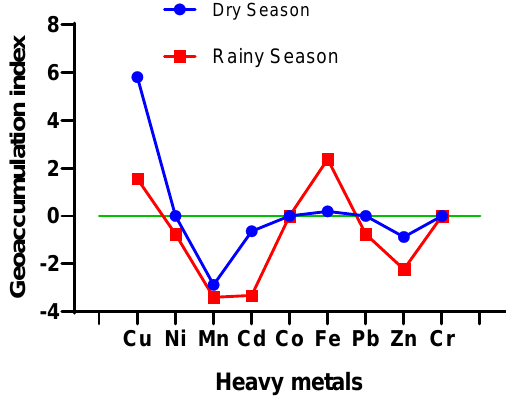
Fig. 3. Seasonal variation of Geo-accumulation